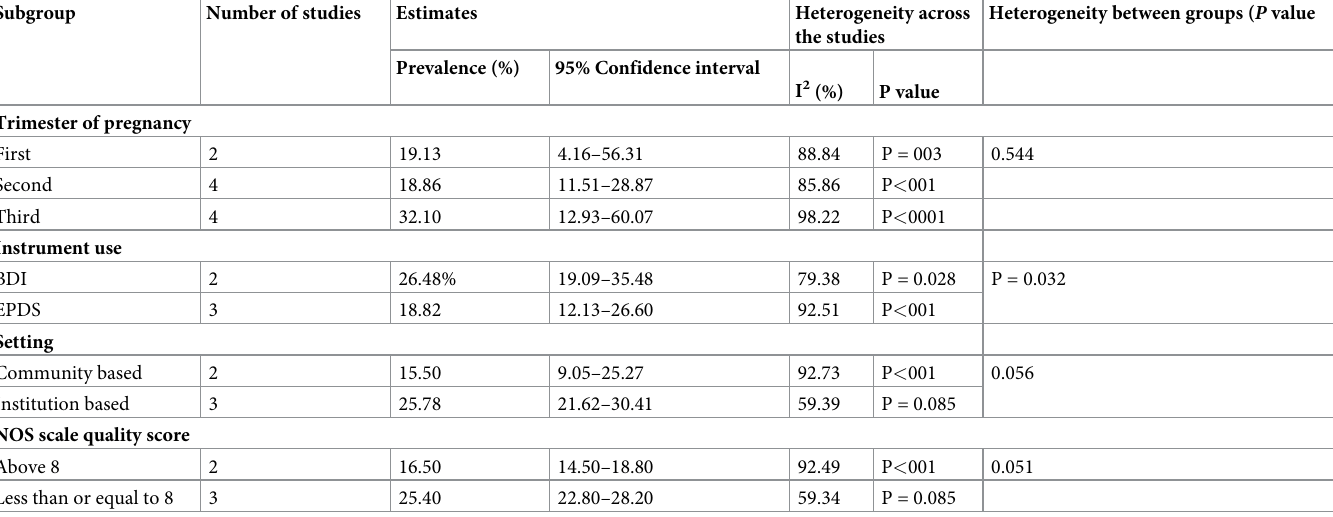
Table 2. Subgroup analysis of the prevalence of antenatal depression in Ethiopia based on random effect